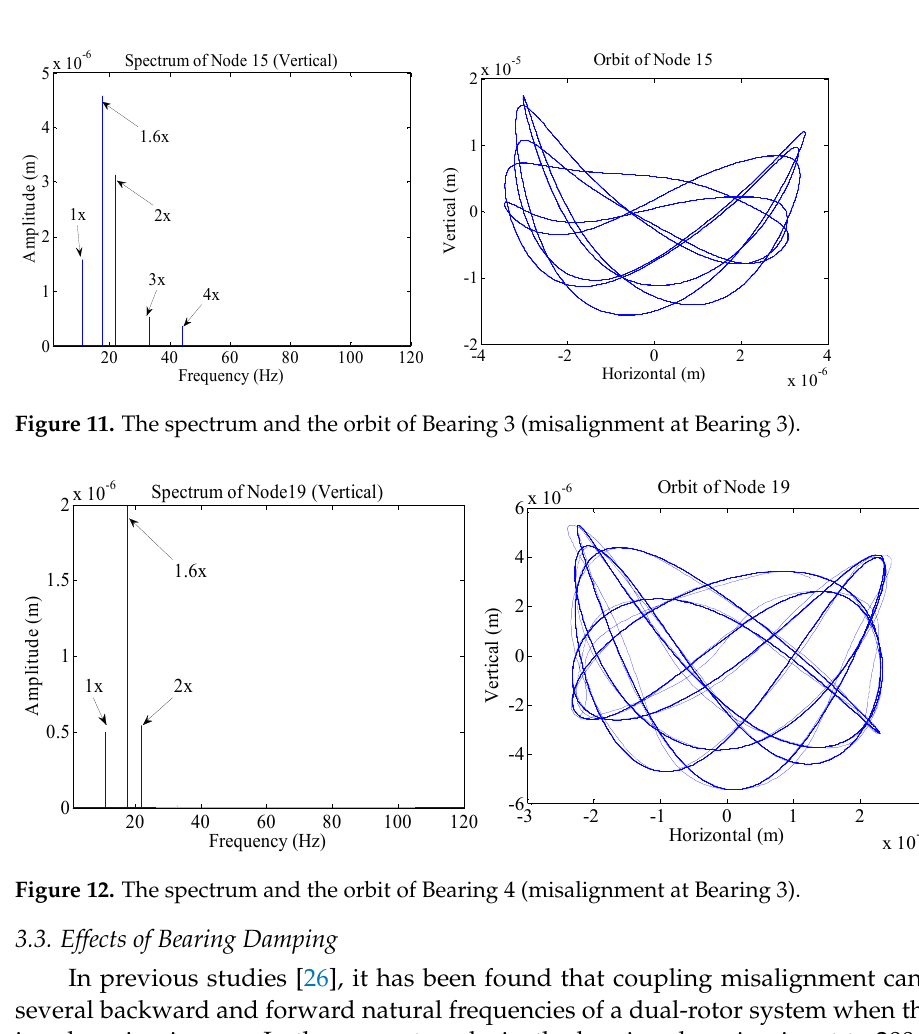
Figure 10. The spectrum and the orbit of Bearing 1 (misalignment at Bearing 3).